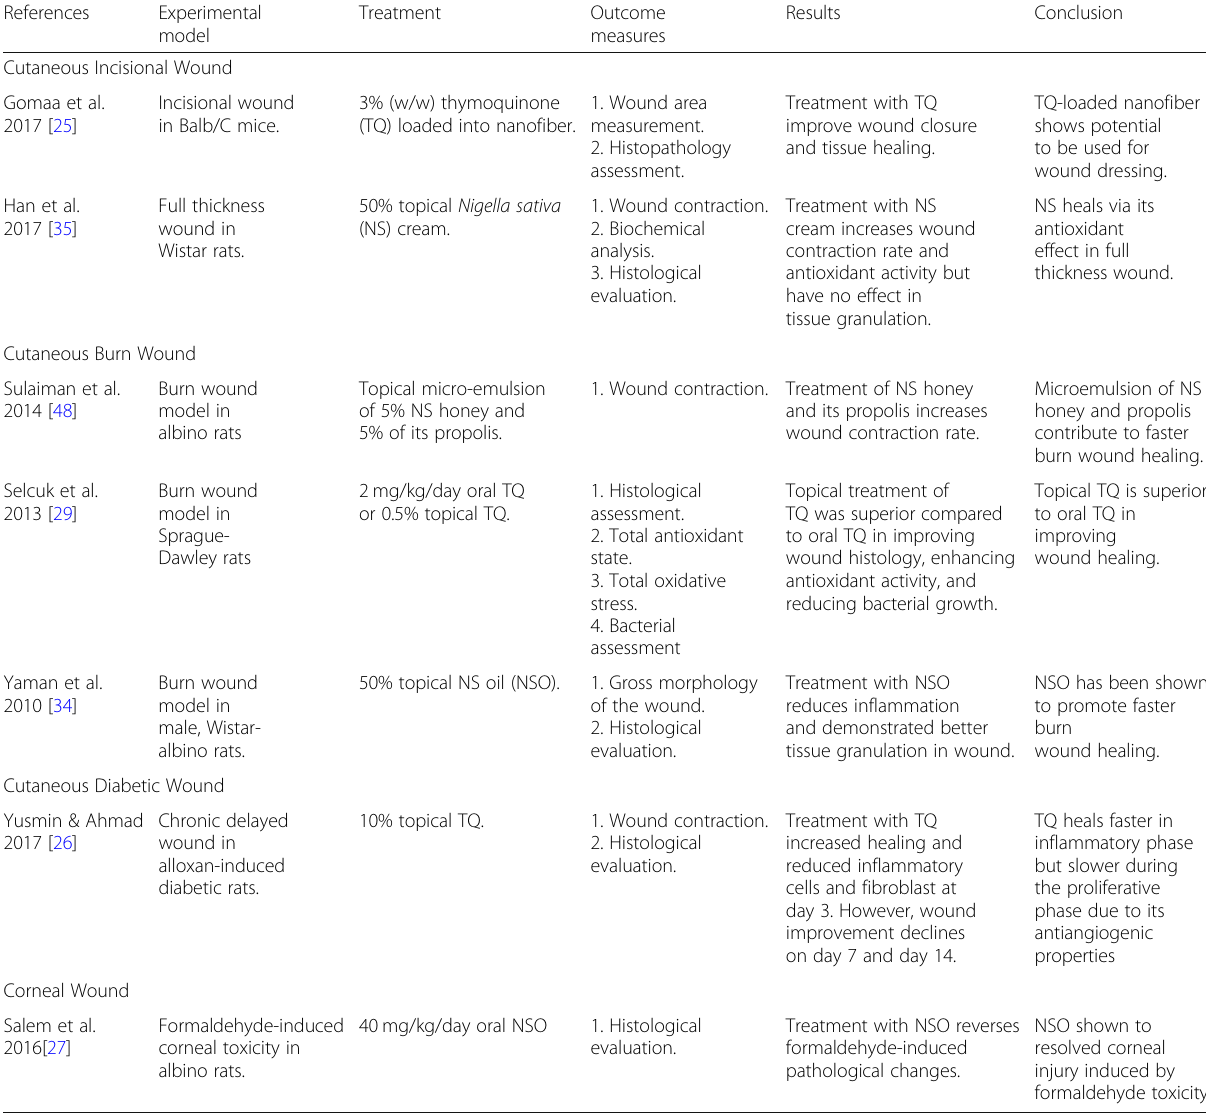
Table 1 Effect of Nigella sativa and thymoquinone in wound